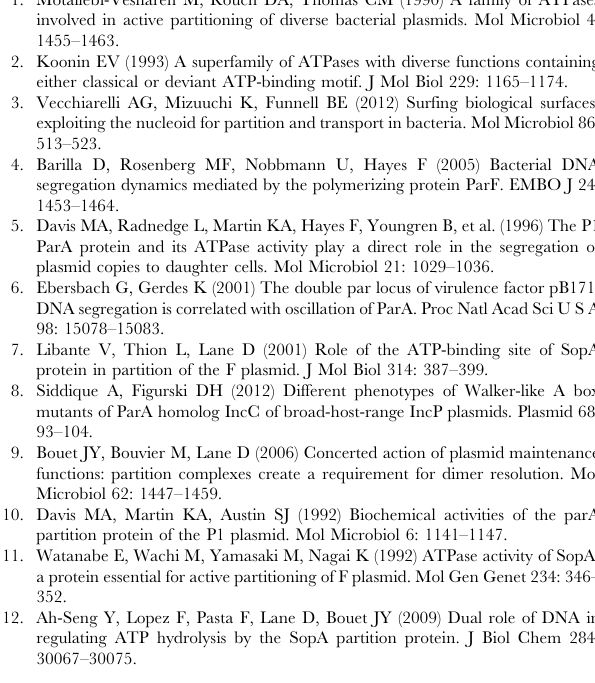
stabilization factors seen with wt SopB and consequently the lower destabilization factors seen with SopB R36A , relative to those obtained with DLT1900. Table S2 Copy number of mini-F pDAG209 (relative to pAM238) provided with wt and mutant SopB proteins. DNAs in mini-preps from cells growing exponentially or in stationary phase in LB at 30 u C were linearized by digestion with Pci I and the fragments quantified by gel-electrophoretic resolution, ethidium bromide staining and fluorescence measurement. Values are averages of two determinations. Fluorescence intensity measure- ments were corrected for the difference in length of the mini-F (7.6 kb) and the SopB-producing derivatives of pAM138 (6.4 kb), to enable calculation of copy number ratios. (DOC) Text S1 Construction of strains carrying V ( para-tetR::egfp ) and D lacZ V ( plac-sopA::xfp